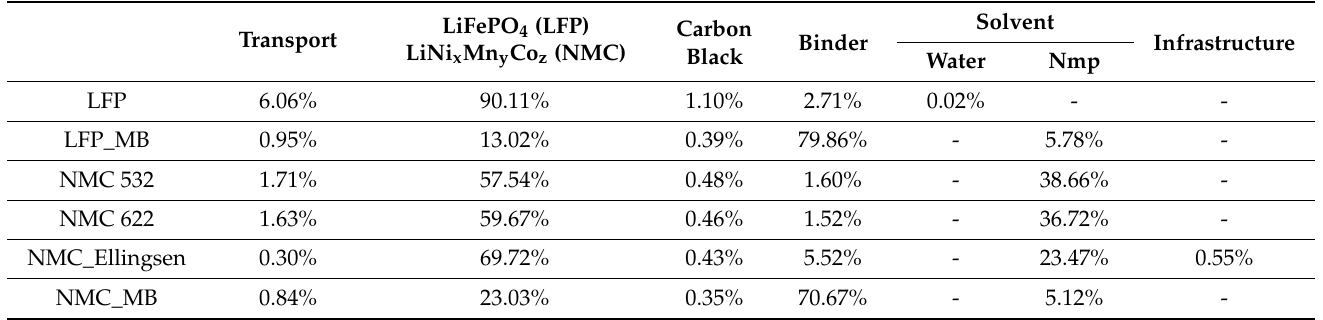
23% for the binder and the oxide of the active material, respectively (Table 4). Table 4. Climate change contribution by process of different batteries technologies and authors (Majeau-Bettez (MB) [21]; Ellingsen et al. [3]) for the production of 1 kg of positive electrode material.